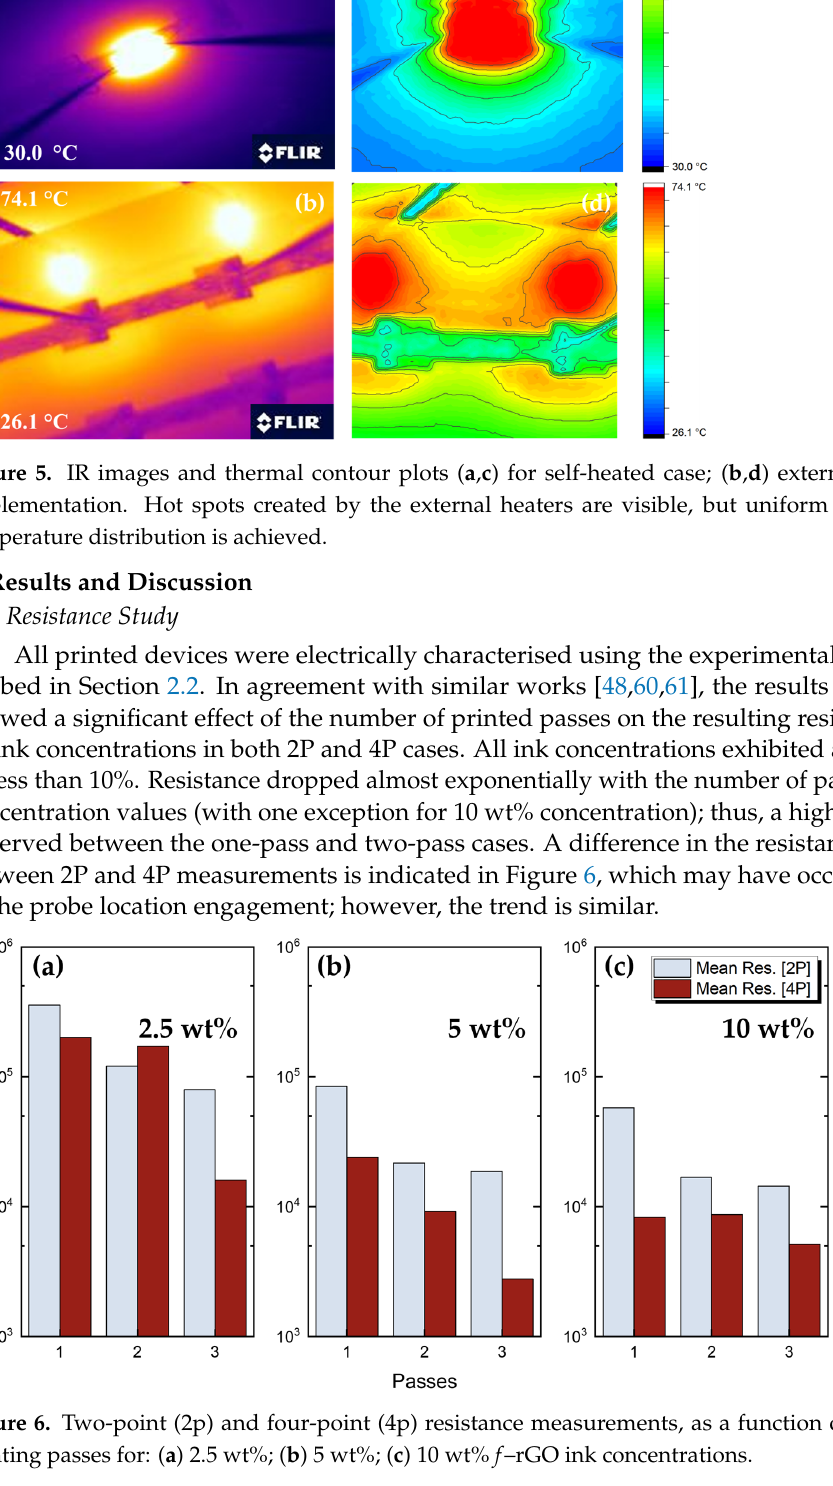
6 of 16 Figure 4. External thermal measuring experimental setup using Pt100 microheaters: ( a ) top view; ( b ) cross-section. Following the first characterisation, the internal heating thermal evaluation was per- formed in order to assess the operation of the printed devices as heaters. Six distinct cur-